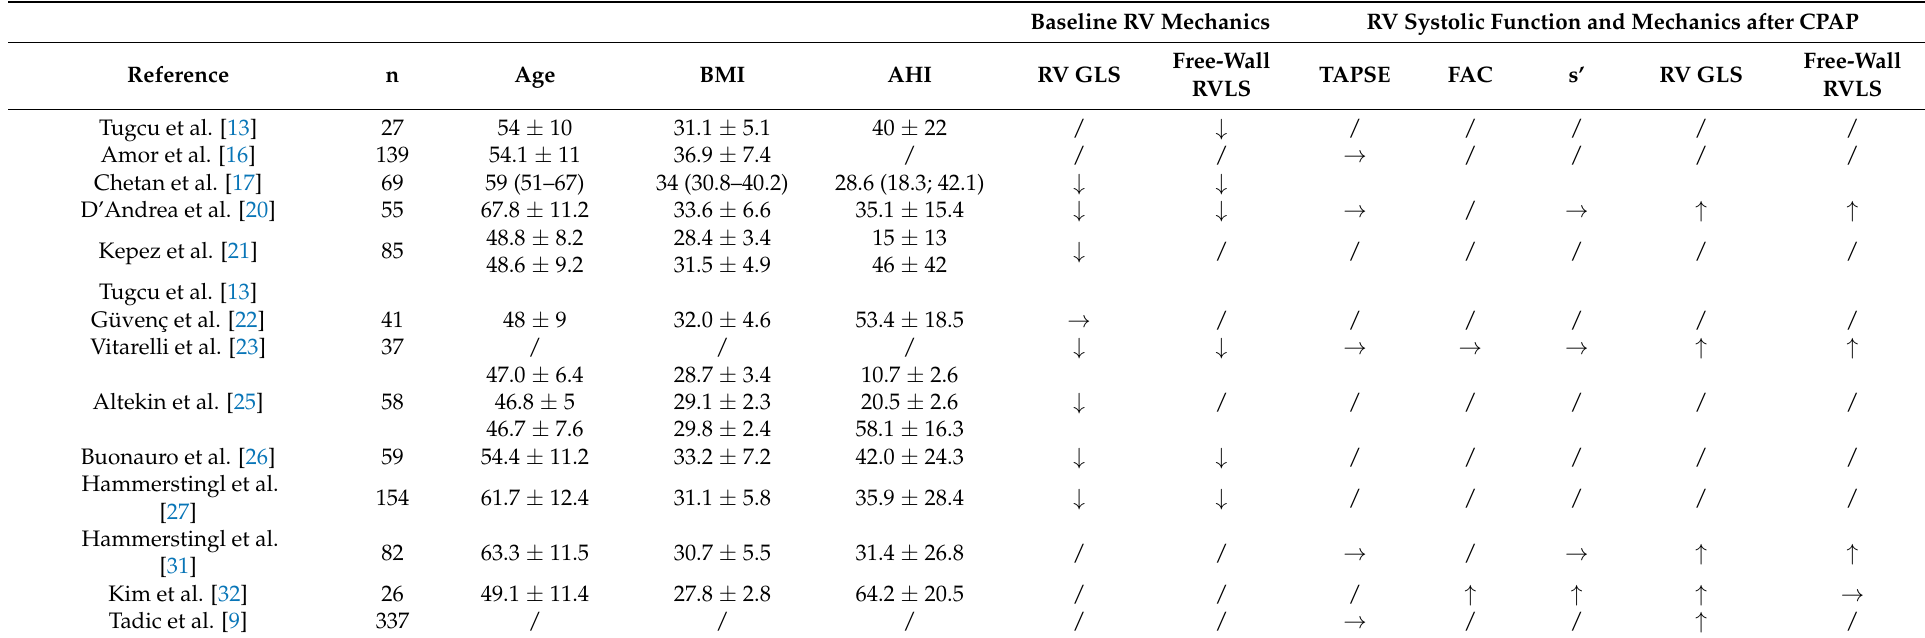
Table 2. RV mechanics in OSA patients at the baseline and after CPAP